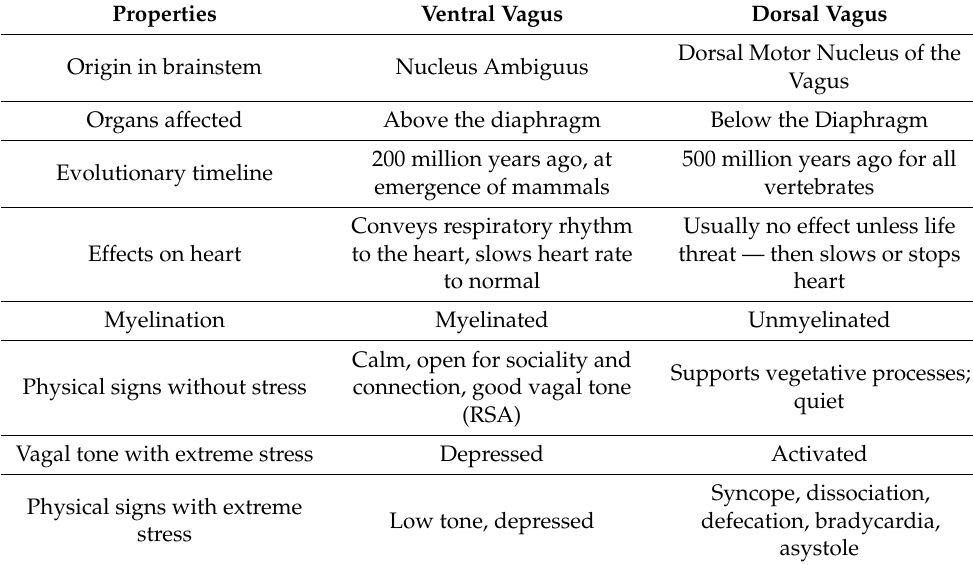
Table 2. Characteristics of two pathways of the vagus